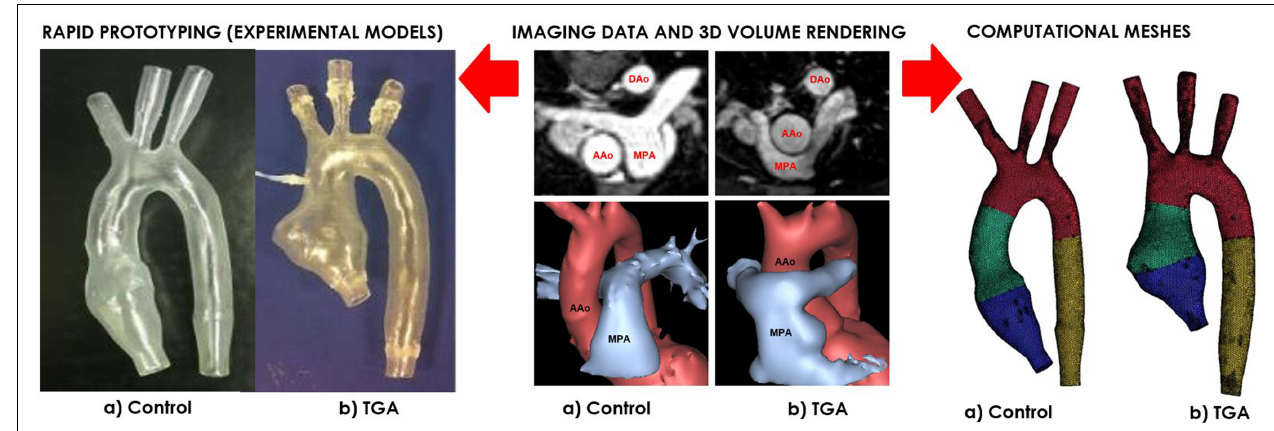
FIGURE 1 | Both control (a) and TGA (b) anatomies are generated from CMR data ( center ) . The exact same 3D volumes are manufactured with rapid prototyping ( left ) and meshed for computational simulations ( right ). Please note typical features of TGA anatomy, particularly the enlarged aortic root with a visible protrusion. AAo = ascending aorta; DAo = descending aorta; MPA = main pulmonary artery.